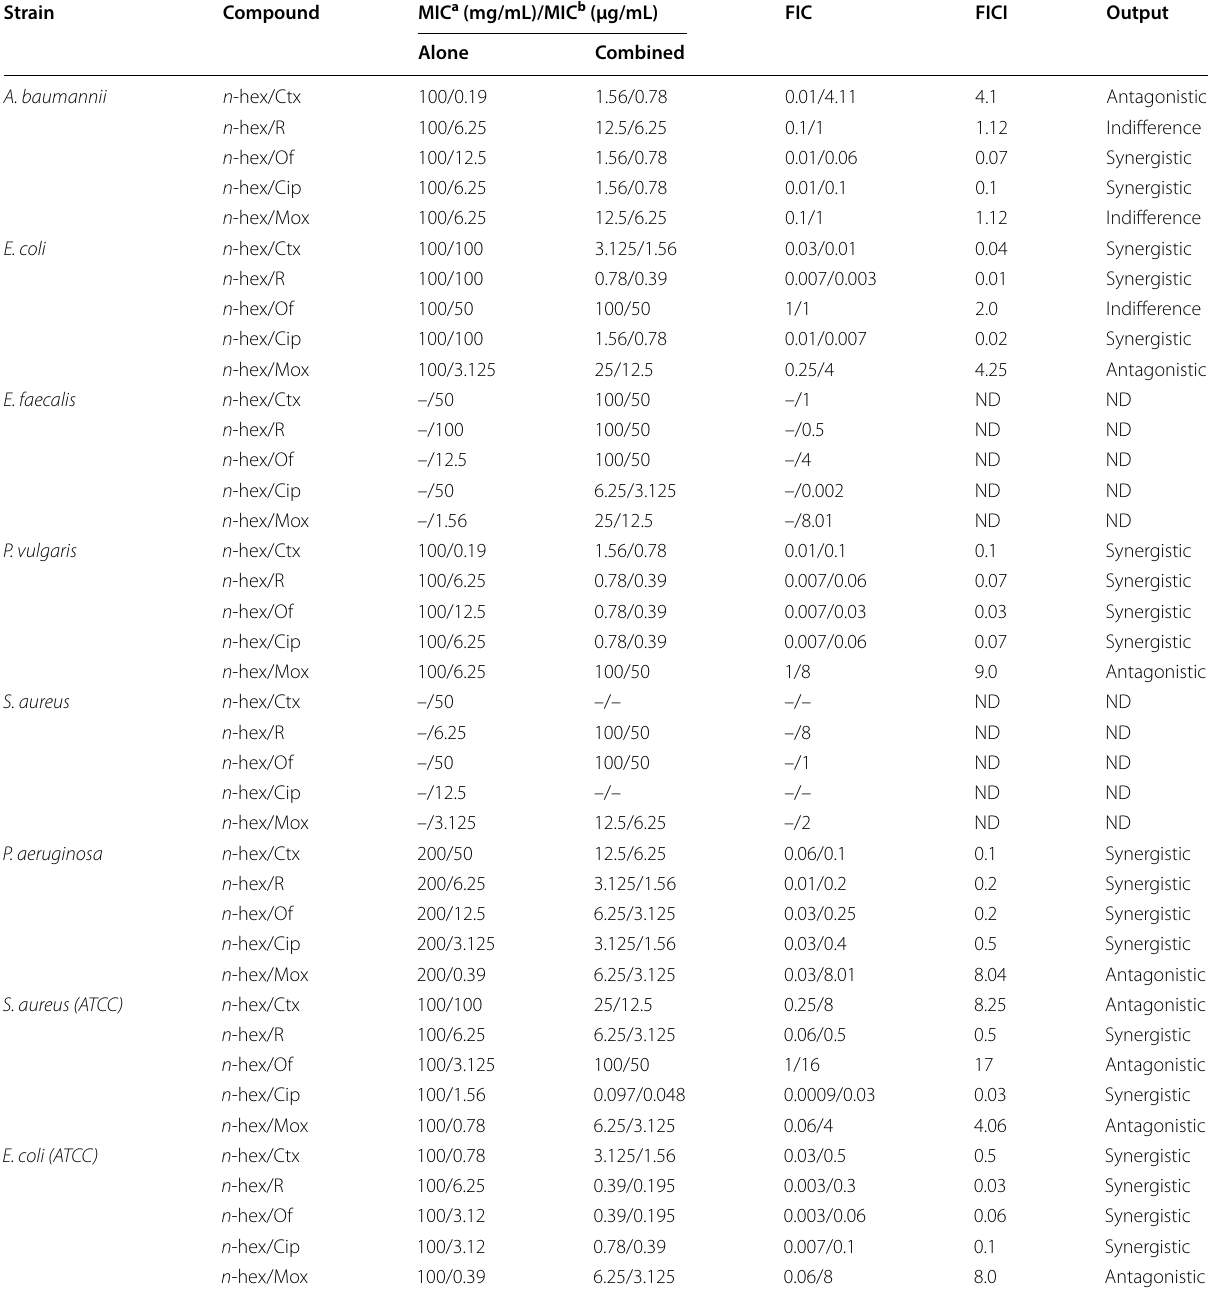
Table 2 Minimum inhibitory concentration (MIC) and fractional inhibitory concentration (FIC) of n -hexane extract, each antibiotic and their combination against clinical pathogenic and reference bacterial